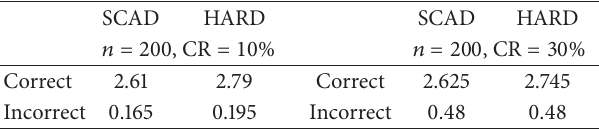
Table 3: Results from the simulation study for scenario (II). The legend is the same as in Table 1.